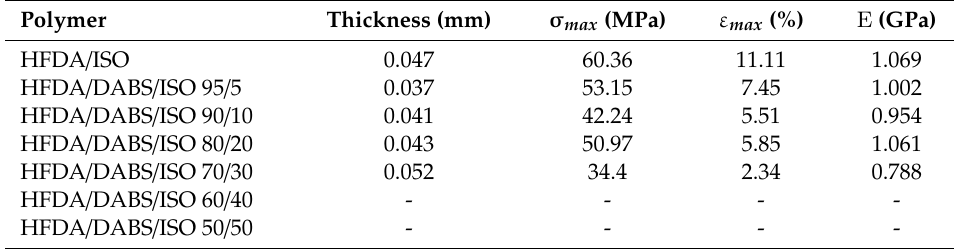
Table 2. Mechanical properties under tension for HFDA / ISO and HFDA / DABS / ISO copolymers. Polymer